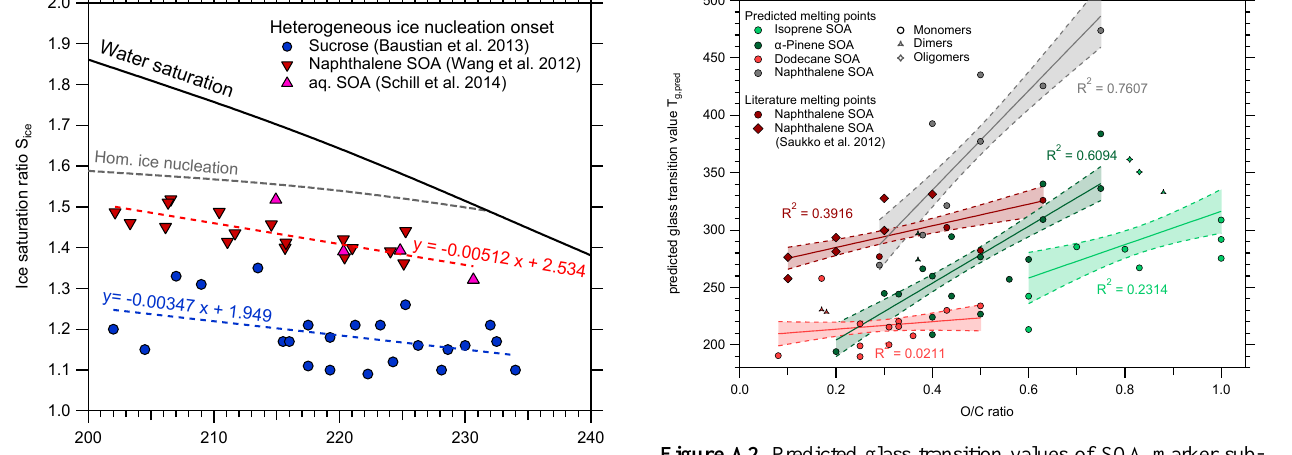
Figure A2. Predicted glass transition values of SOA marker sub- stances as a function of O / C ratio. The predicted T g,org exhibits a linear correlation with O / C for each of the four SOA systems. Solid lines are robust linear regressions using a bisquare weighting function and shaded areas are confidence intervals at the 1 σ level. Anthropogenic aliphatic SOA constituents show the lowest values of T g,org and a weak dependence on O / C. In contrast, aromatic SOA shows the highest glass transition values despite a rather low average O / C ratio. Table A1. Assumed physical properties of SOA classes for use in conjunction with the diffusivity estimation